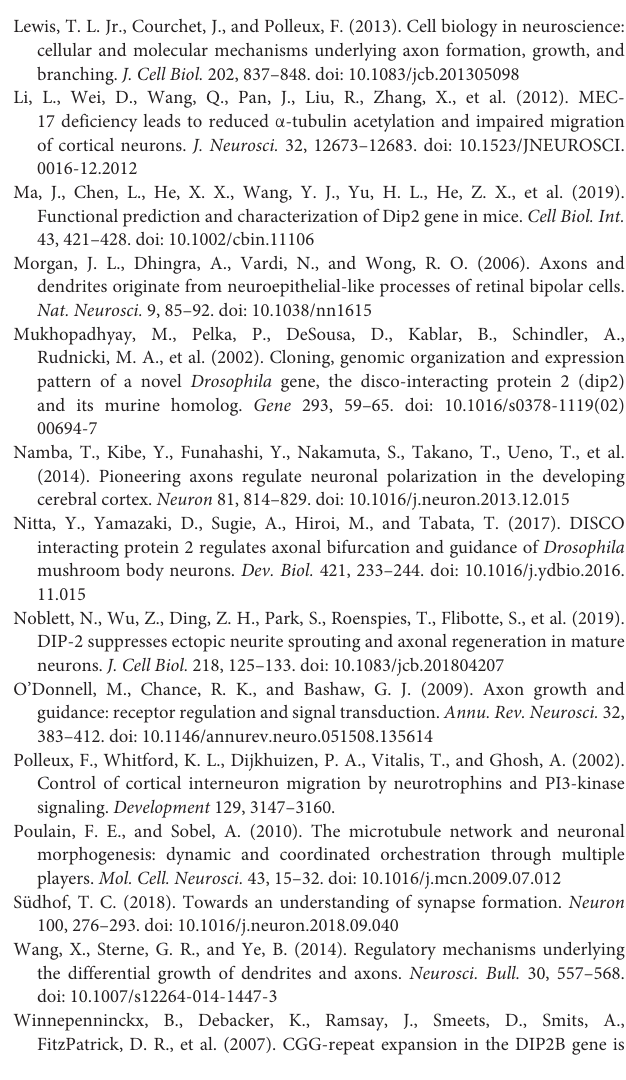
FIGURE S1 | DIP2B expression at the cellular level. (A) Immunocytochemistry of the LacZ with NeuN; (B) LacZ with GFAP; (C) LacZ with CamKII; (D) LacZ with GABA. (E) Relative quantification of LacZ, NeuN, and GFAP positive cells. (F) Relative quantification of LacZ, CamKII, and GABA positive cells. Scale bar: 20 µ m. FIGURE S2 | DIP2B is critical for axonal outgrowth in cKO mouse neurons. (A,B) DIP2B conditional knockout efficiency. Ctrl: DIP2B floxp/floxp , cKO: DIP2B floxp/floxp ; NEX -Cre. (C) Representative images of axonal development during the first 40 h of plating from Ctrl and cKO mice. Scale bar: 20 µ m. (D) The average percentage of unpolarized to total neurons. (E) Average traces of neurites outgrowth during the first 40 h of plating (Ctrl, n = 40; cKO, n = 42). (F) Average axonal growth rates from panel (D) . An unpaired t- test was used for comparisons.